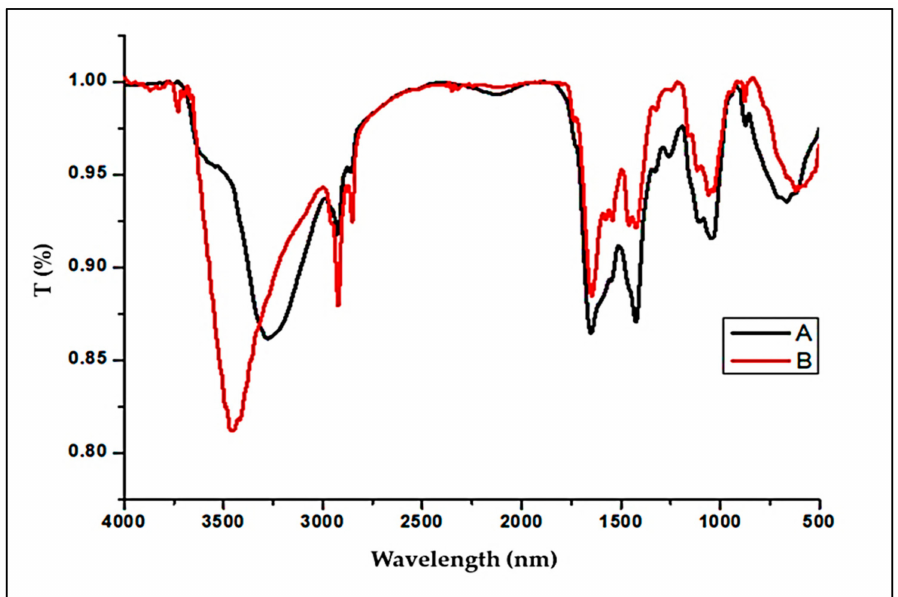
Figure 1. FTIR spectroscopy of P. capillacea nanoparticles before (A) and after adsorption (B) of IV2R dye from an aqueous